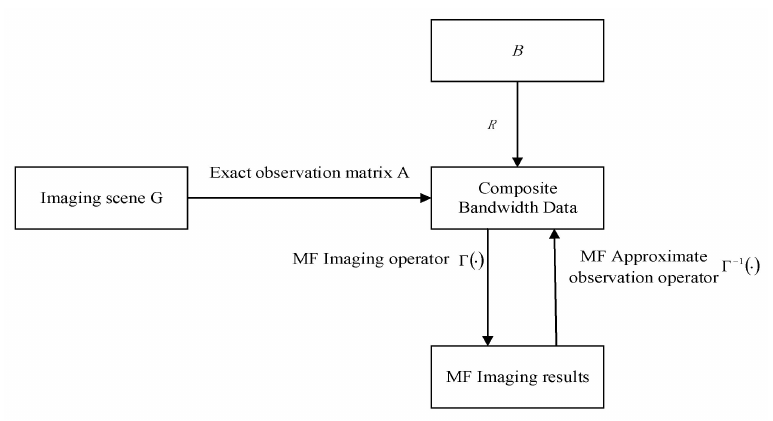
Figure 3. Approximate observation model of